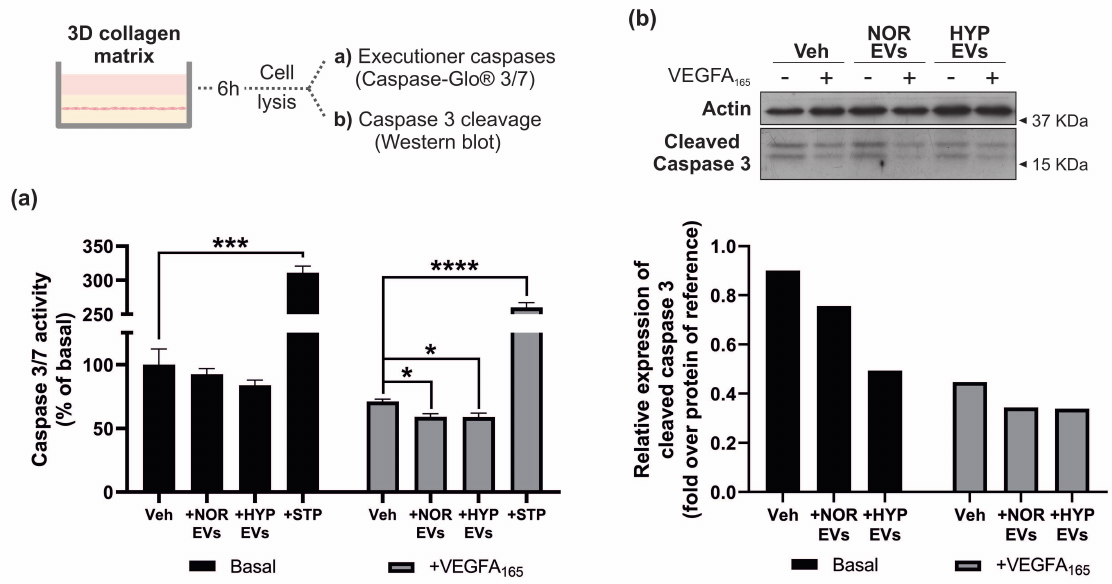
Figure 4. hUCMSC-derived EVs reduce caspase-3/7 activation during tubular morphogenesis. Serum starved HDMECs were plated between two layers of collagen I gel and stimulated with 10 7 NOR/HYP EVs or 100 nM staurosporine (STP) and/or 50 ng/mL VEGFA 165 for 6 h. Cells were lysed either with ( a ) Caspase-Glo ® 3/7 reagent and measured caspase-3/7 activity via luminescence, or ( b ) LDS buffer and immunoblotted with antibodies against cleaved caspase 3 and actin. Data in ( a ) is presented as mean ± SEM of percentage over the basal from n = 3 replicates, each measured in duplicate (mean of technical duplicates was used for analysis). Statistical analysis: two-way ANOVA showed p < 0.0001 for both studied factors: ± VEGFA and ± EV/STP treatments; unpaired t -tests between groups are shown in the figure, where * p < 0.05, *** p < 0.001 and **** p <